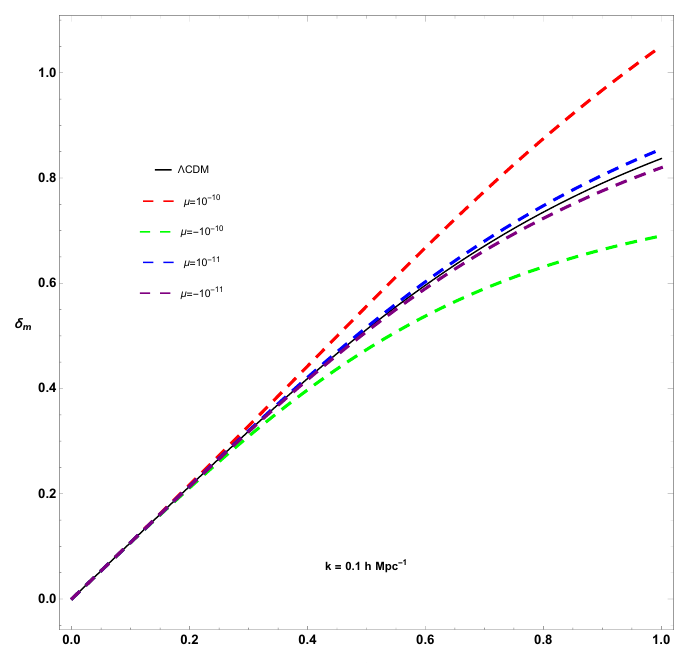
Figure 6. Matter growth in the presence of anisotropic stresses ( m = α = β = ν = c 2 ε =